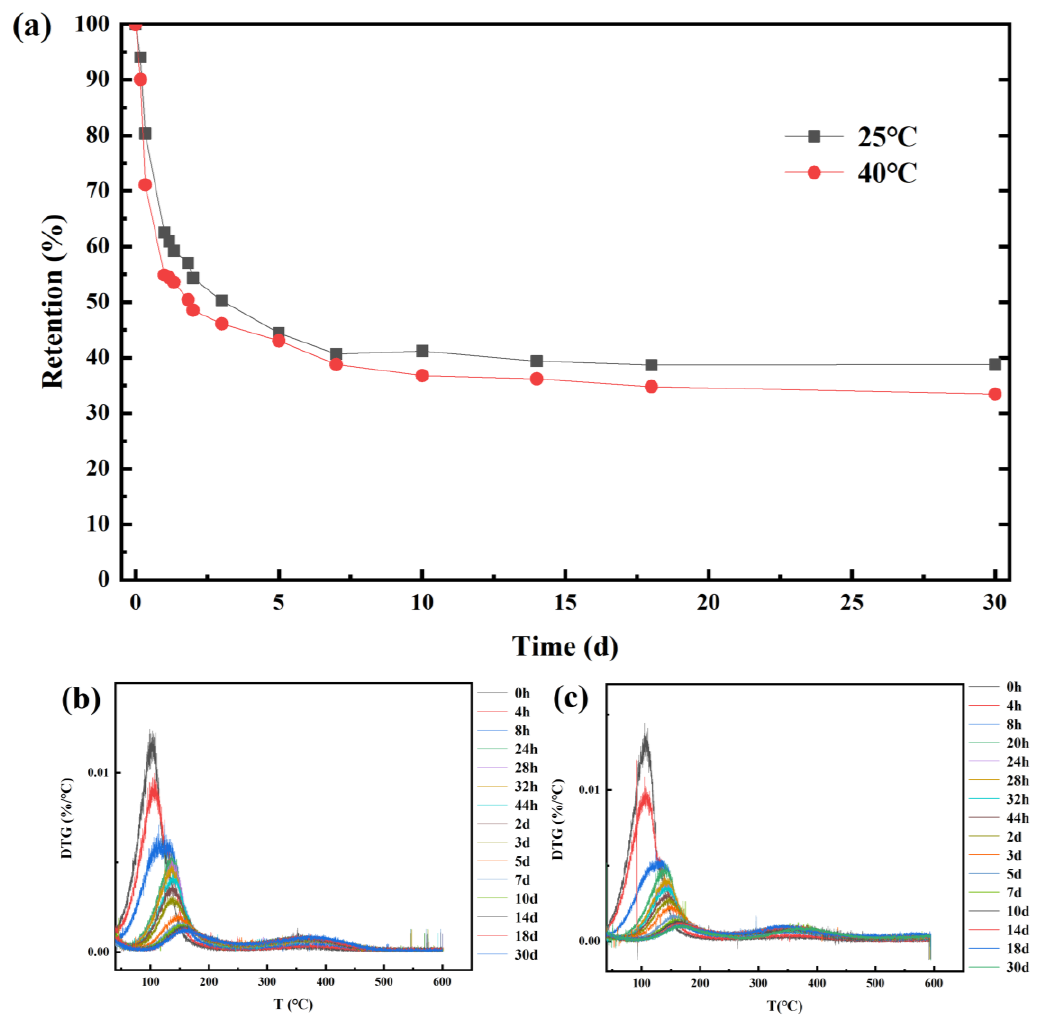
Figure 6. The curve of retention ( a ) of CEO−SNP at different time in environment at 25 °C and 40 °C . The curve of DTG of CEO−SNP at different time in environment at 25 °C ( b ) and 40 °C ( c